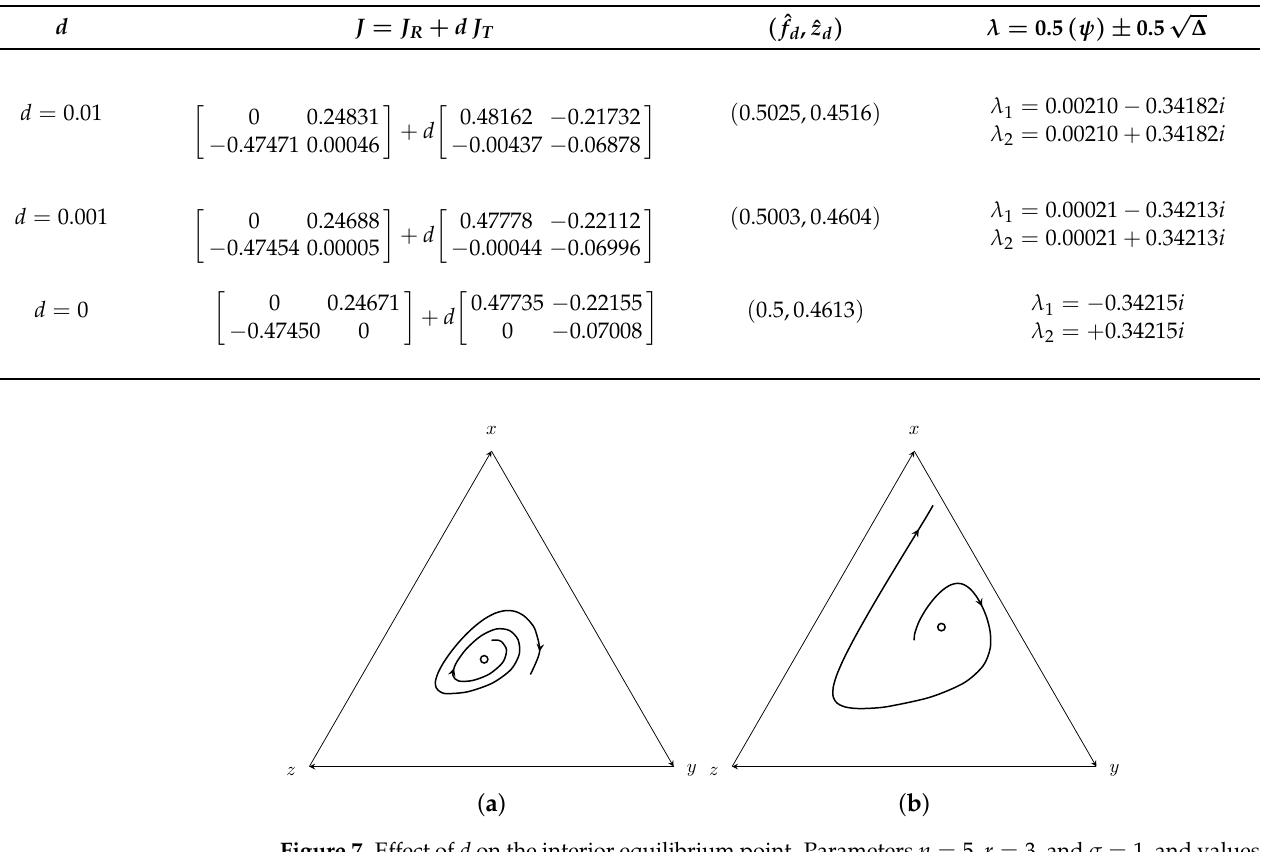
Figure 7. Effect of d on the interior equilibrium point. Parameters n = 5, r = 3, and σ = 1, and